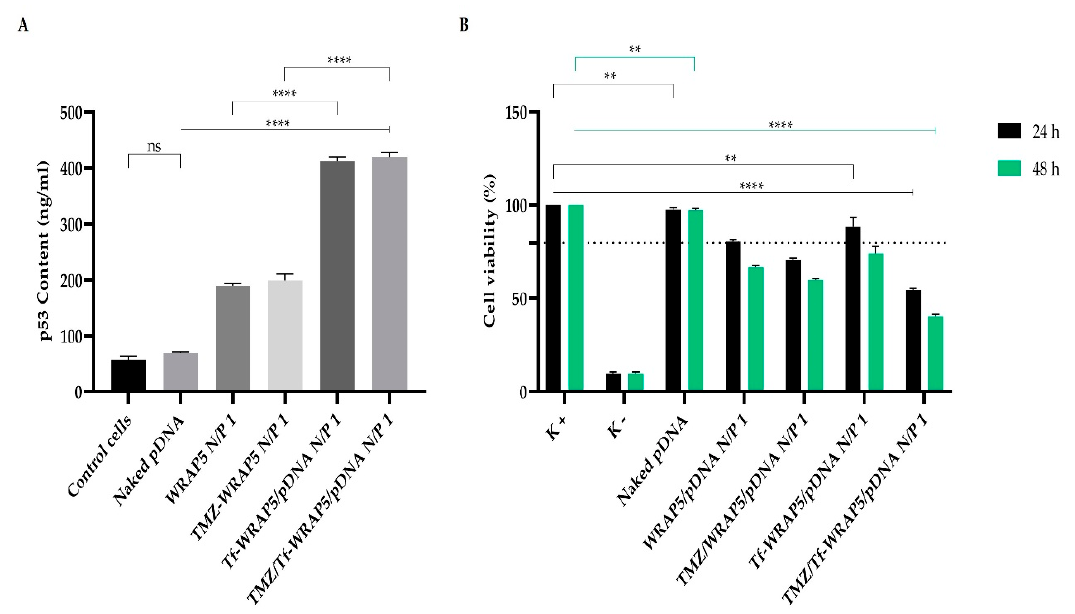
Figure 7. ( A ) Quantification of p53 protein levels (ng/mL) in U-87 cells after 48 h of transfection mediated by the different complexes developed at an N/P ratio of 1. The values were calculated with the data obtained from three independent measurements (mean ± SD, n = 3) and analyzed by one-way ANOVA with the Bonferroni test. For all complexes, ****, p < 0.0001 relatively to control cells. ( B ) Cellular viability of U-87 cells after 24 h and 48 h of incubation with WRAP5/pDNA, TMZ/WRAP5/pDNA, Tf-WRAP5/pDNA and TMZ/Tf-WRAP5/pDNA complexes prepared at N/P ratio of 1. Non-transfected cells were used as a positive control (K+) and cells treated with ethanol were used as negative control (K − ). Statistical analysis was completed using one-way ANOVA with data obtained from four independent measurements (mean ± SD, n = 4). (****, p ≤ 0.0001; **, p ≤ 0.01). ns—statistically non-significant.